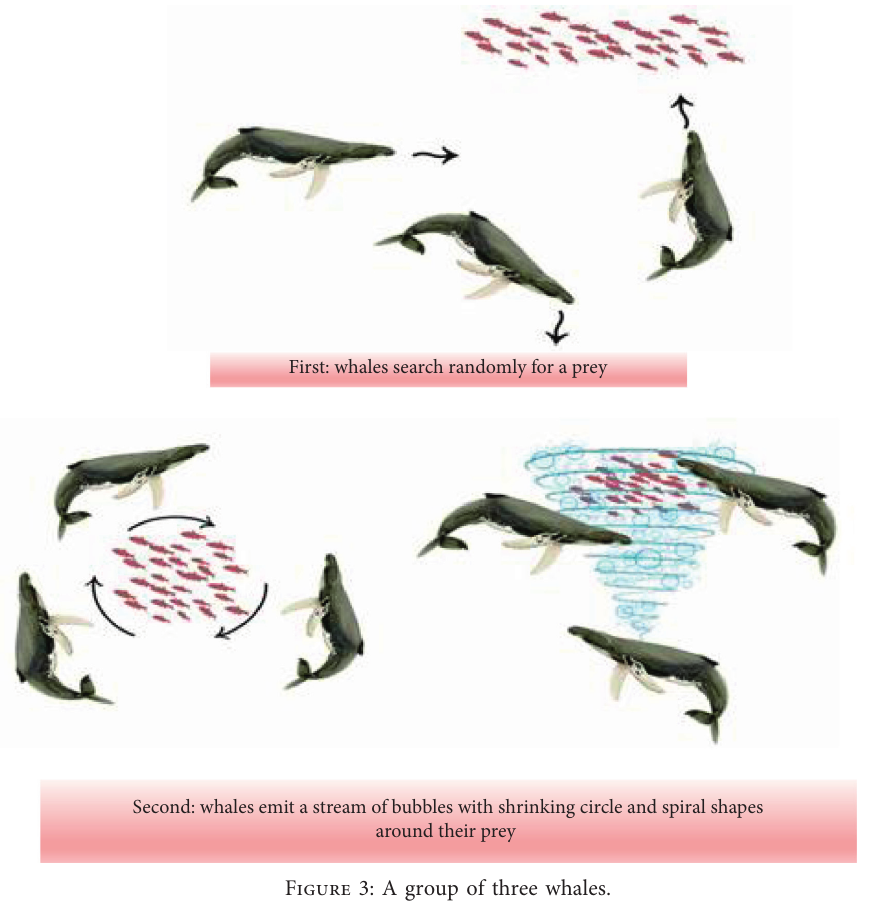
Figure 3: A group of three